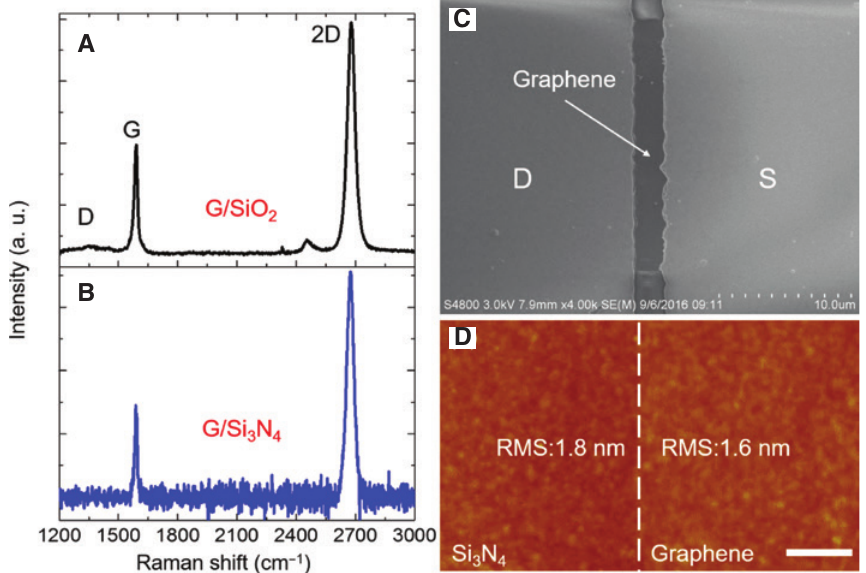
Figure 4: Raman spectra of the transferred graphene on the surface of silica (A) and silicon nitride (B) indicate that the surface of the pas- sivation layer on the IC chip did not bring any additional damages to the performance of the graphene. (C) The scanning electron microscopy image shows the graphene channel clearly due to high electrical conductivity of the graphene material. (D) The atomic force microscopy image at the boundary of graphene and silicon nitride shows more details of the graphene material and silicon nitride. The scale bar is 500